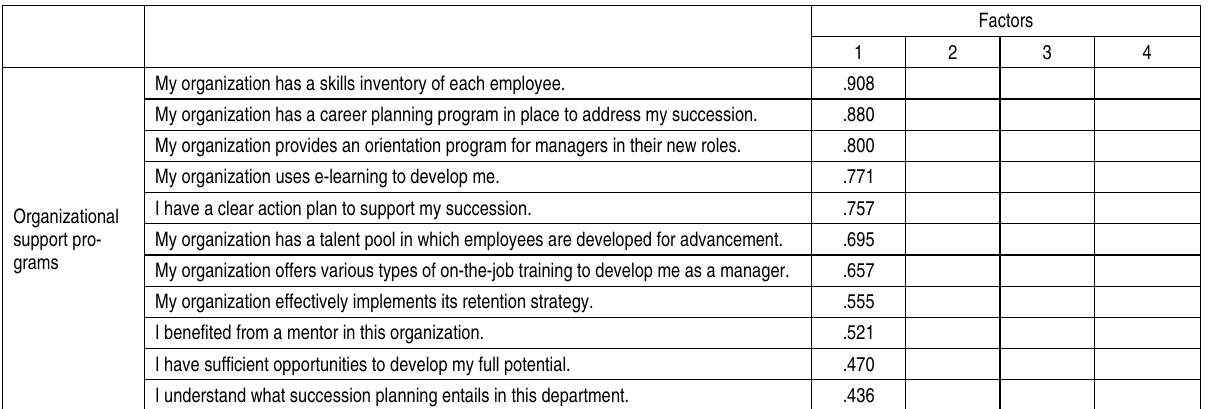
Table 2. Four-factor analysis